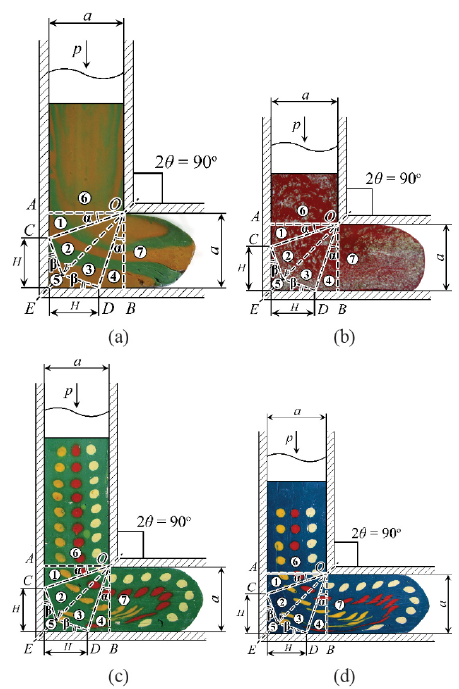
Figure 5. Physical models of the shape of material dead zone CEDF during ECAE through a Segal die with channel intersection angle 2θ=90° with an introduction of layered workpiece models (a), solid marker techniques (b), and initial circular gridlines (c,